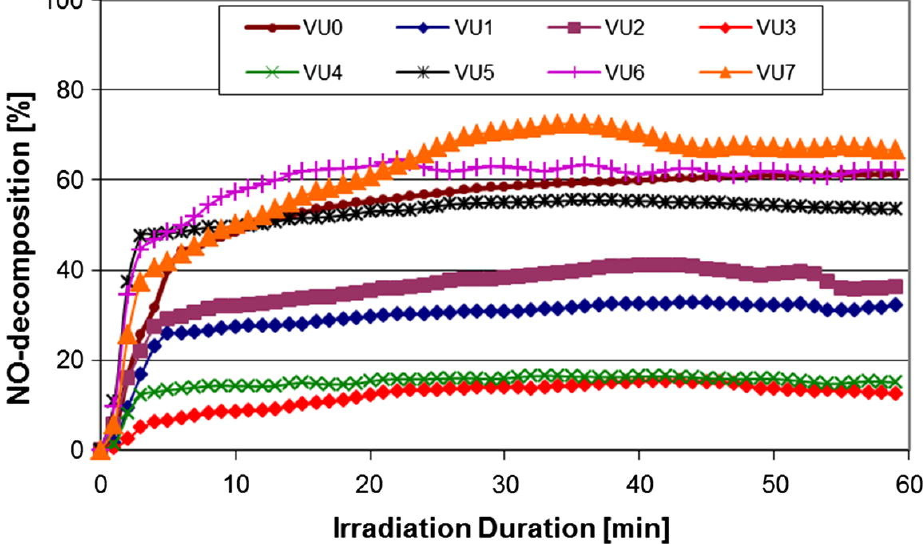
Figure 5. Average degradation efficiencies of NO for all studied specimens [119] . Eight TiO 2 products (VU0 to VU7) with varying grain size, anatase proportions, and surface area. VU0 is the reference commercial cement mixture.